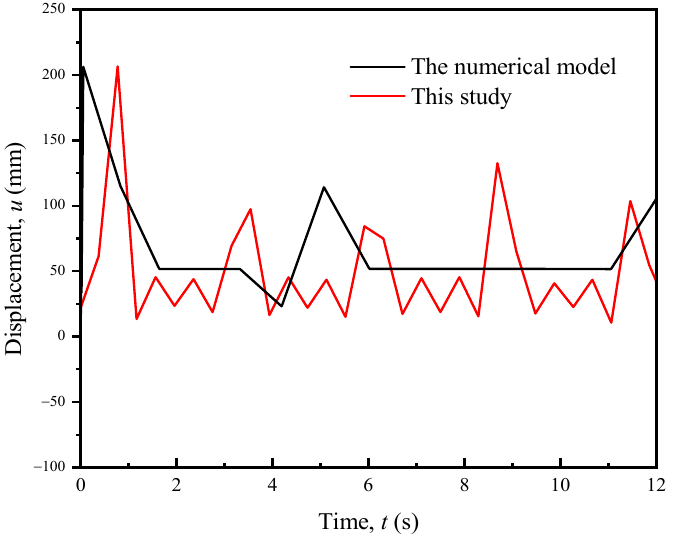
Figure 7. Comparison of displacement curves predicted from this study and the numerical result.